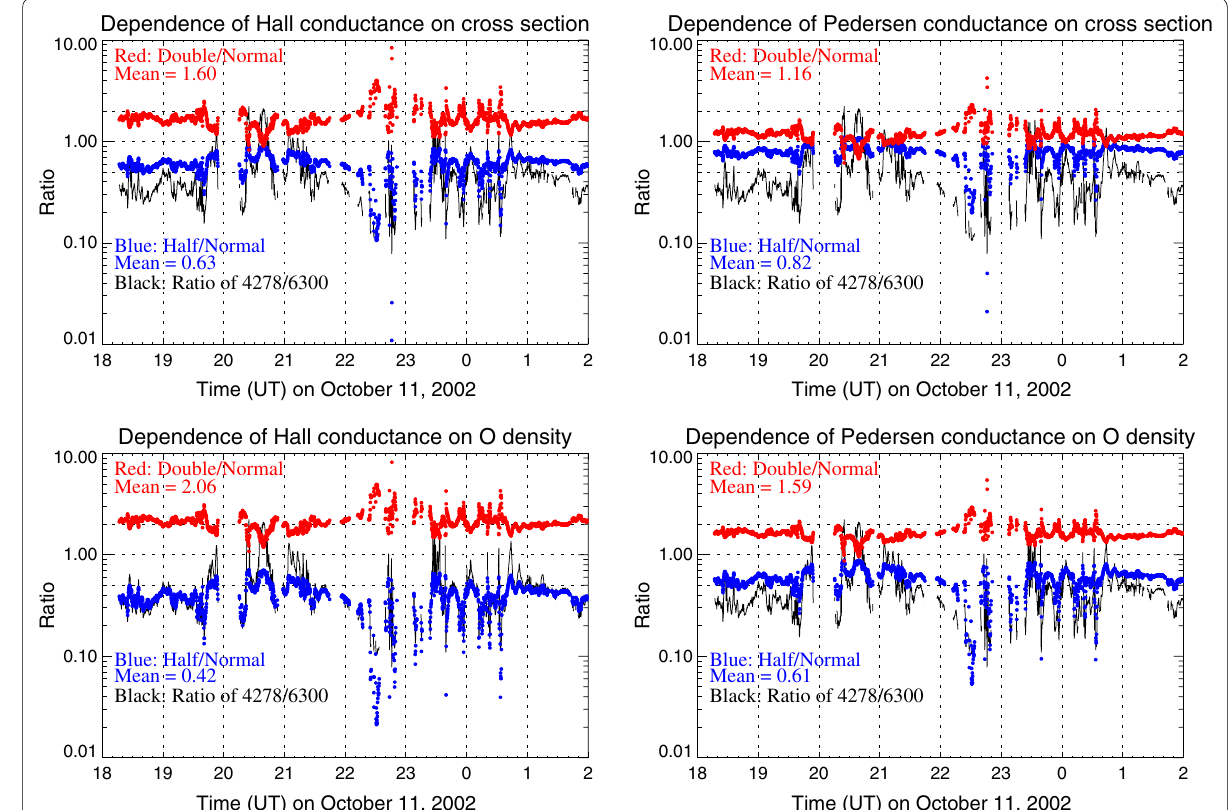
Fig. 18 Temporal variations of the ratios of height-integrated conductivities for October 11, 2002; The same as Fig. 17 except for October 11, 2002